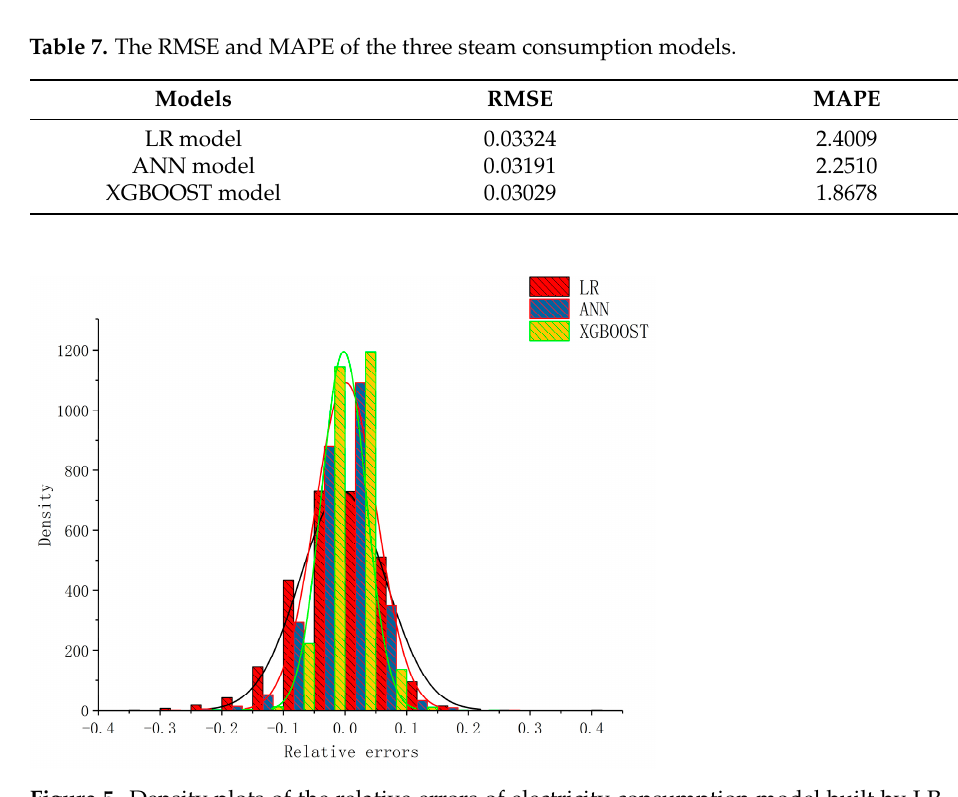
Figure 5. Density plots of the relative errors of electricity consumption model built by LR, ANN and XGBOOST.